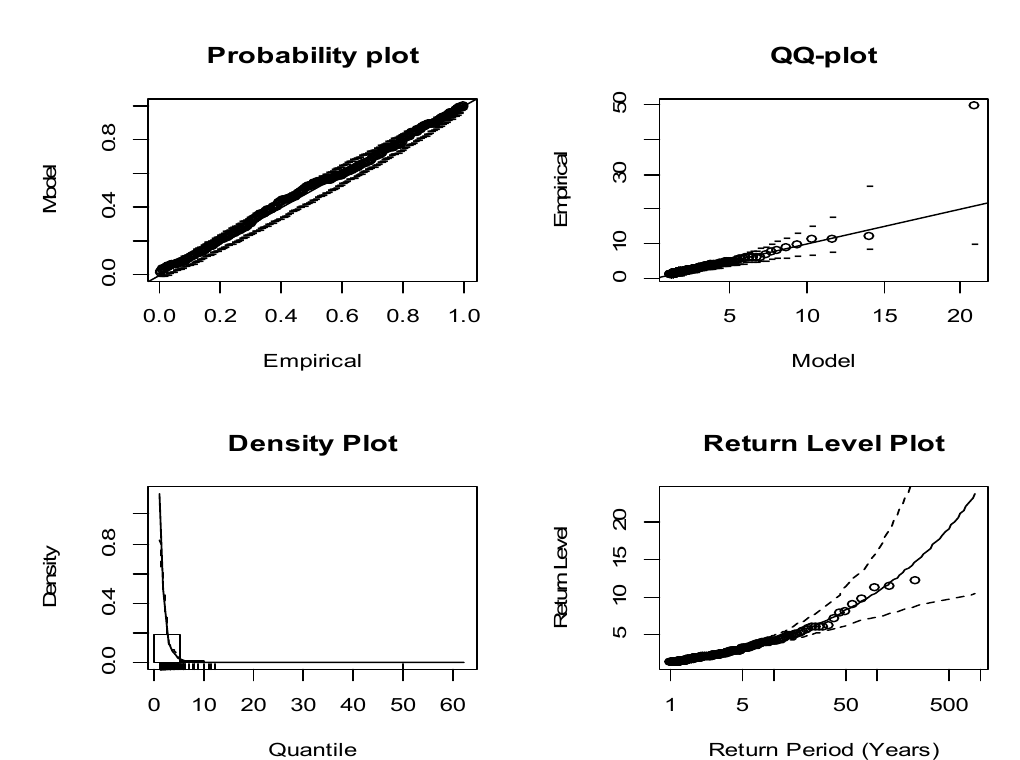
Figure 5. Diagnosis plot of gains.